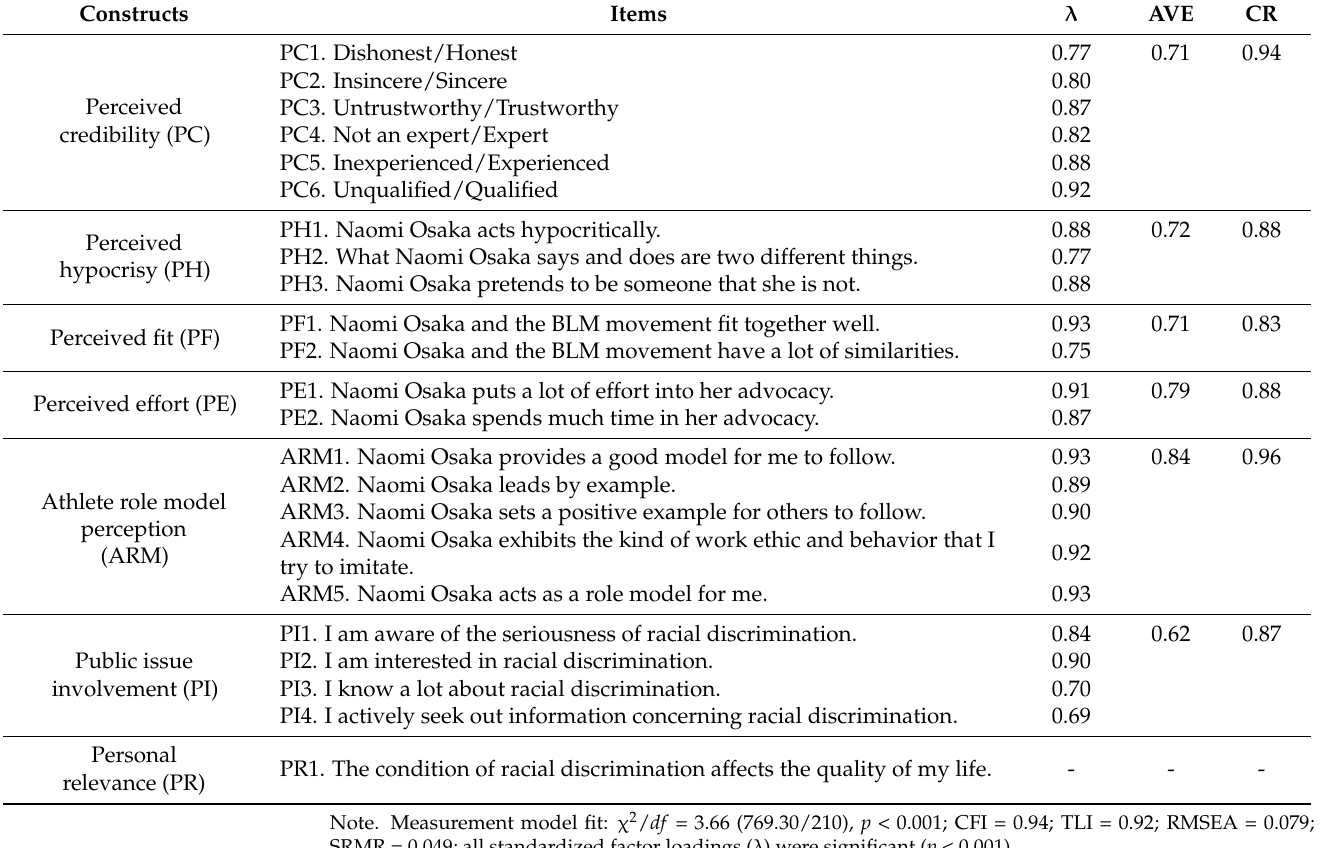
Table 2. Standardized factor loadings ( λ ), average variance extracted (AVE), and composite reliability (CR) for the measurement model (Sample A: n =